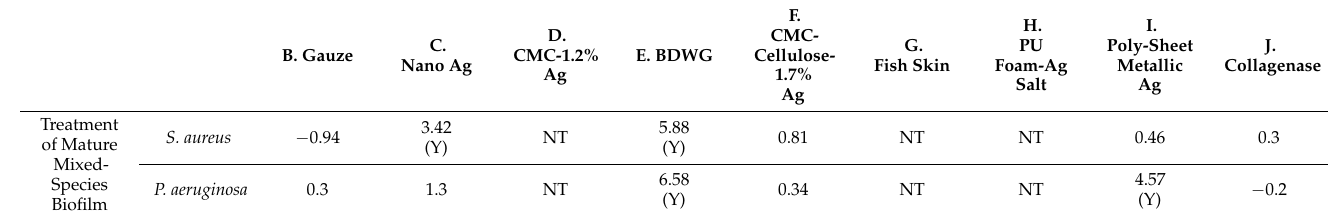
Table 2. Log CFU reduction of S. aureus and P aeruginosa species in comparison with untreated con- trols in a mixed-species DFR mature biofilm treatment assay.